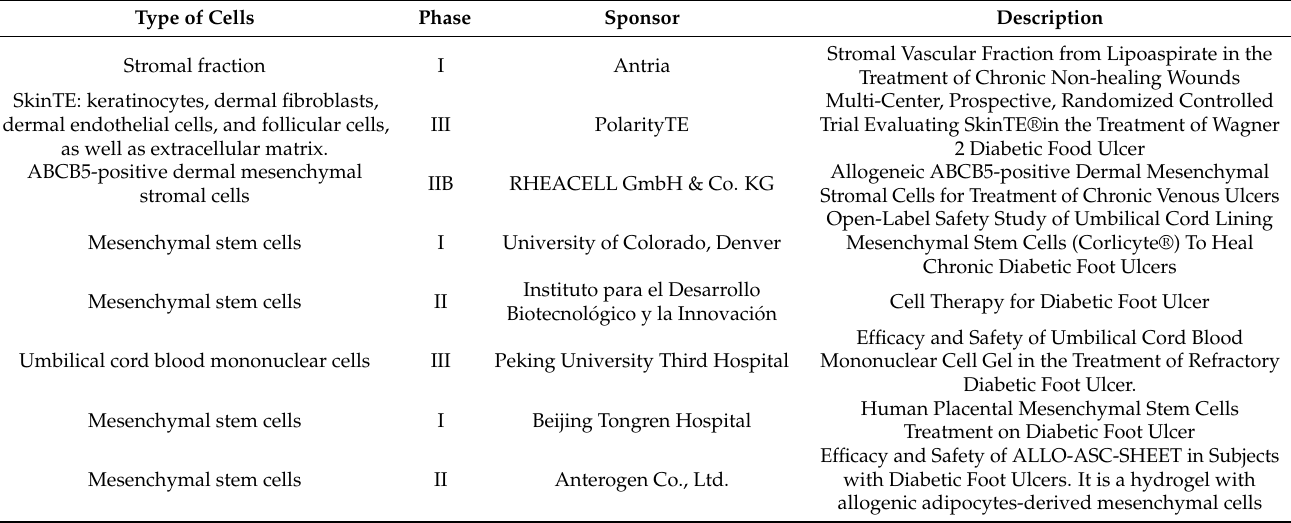
Table 1. Representative clinical trials in course for cell therapy and tissue engineering for chronic wounds *.